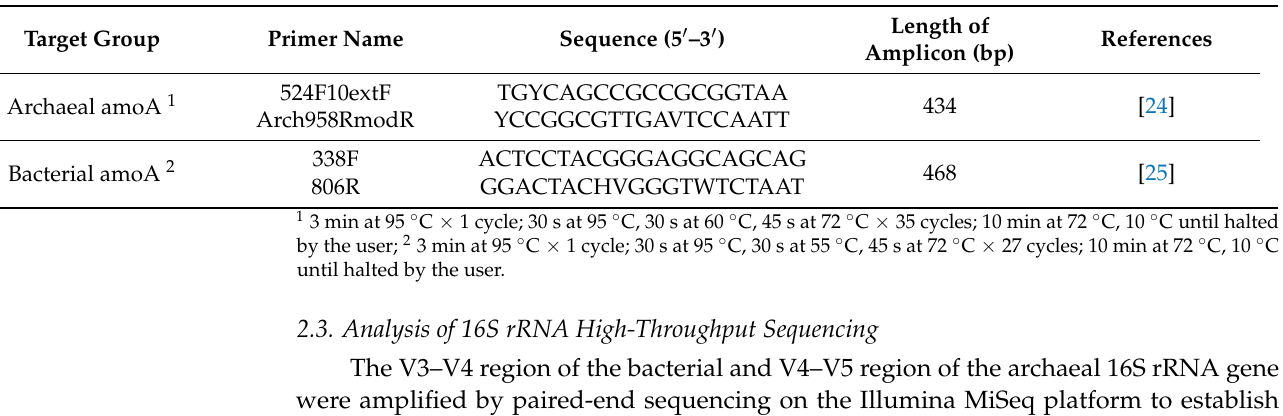
Table 1. Amplification primers and reaction conditions of real-time fluorescence-based quantita- tive